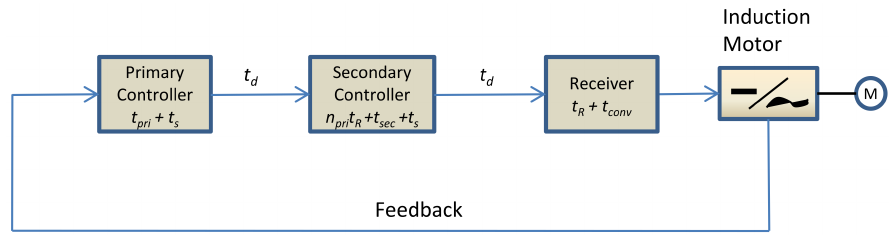
Figure 5. Microgrid’s primary and secondary distribution control